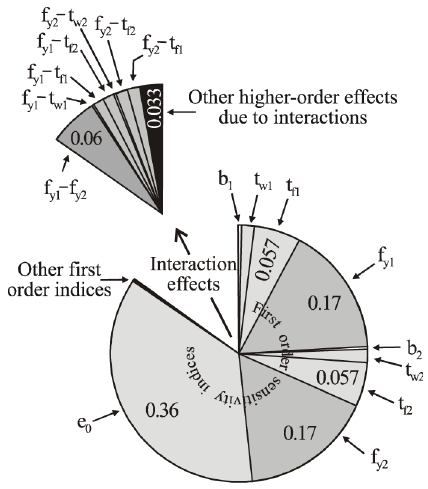
Fig. 7. Sensitivity analysis – Frame 2, h = 3 m